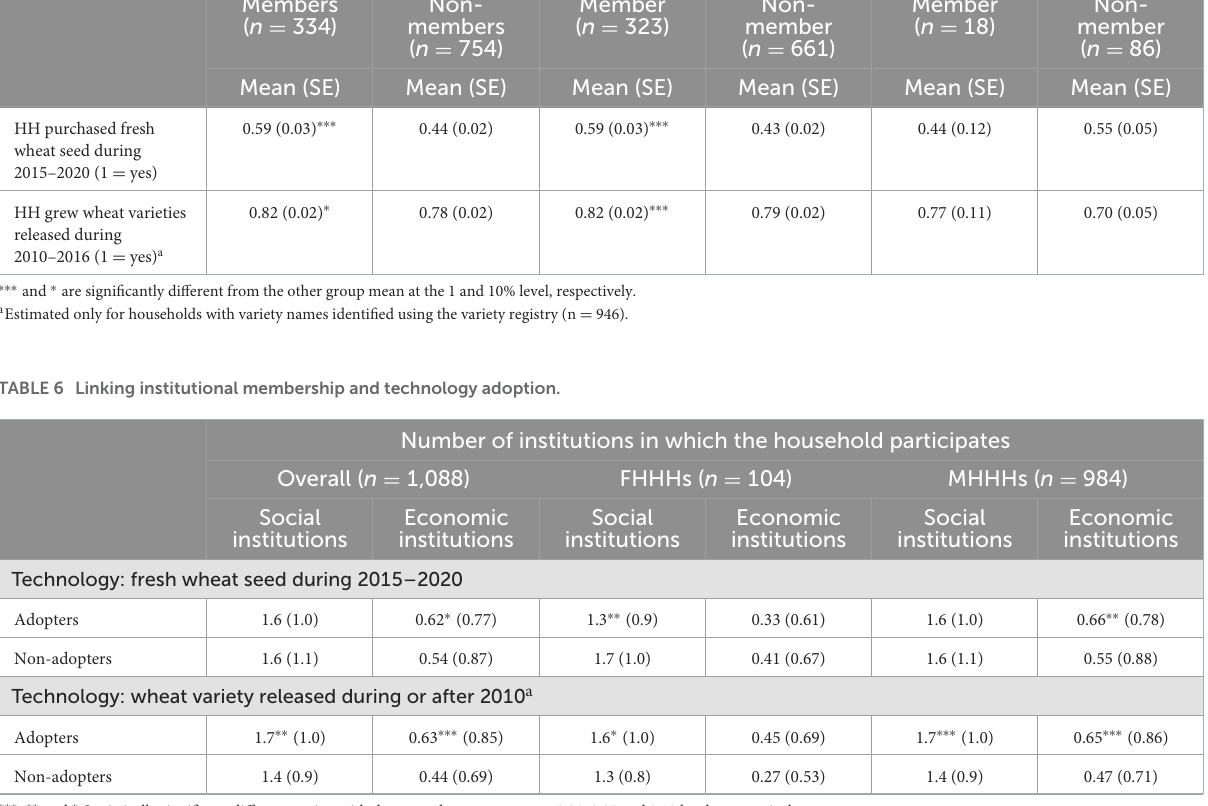
TABLE 5 Cooperative membership and seed acquisition by gender of the household head.